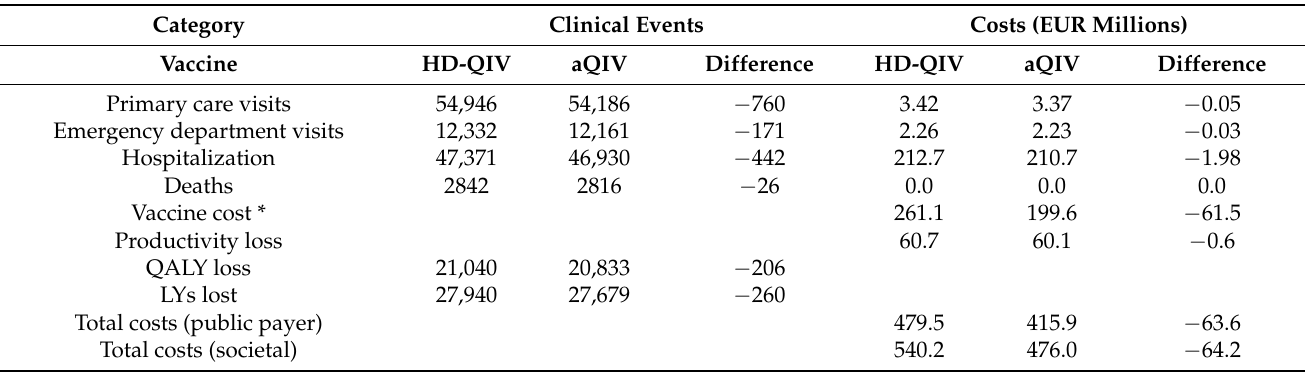
Table 3. Total and incremental costs and outcomes associated with aQIV and HD-QIV when used to vaccine people aged 65+ in